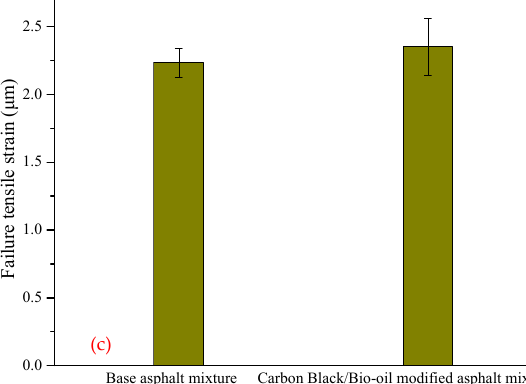
Figure 8. Comparison of low-temperature splitting test results of different asphalt mixtures. ( a ) Splitting tensile strength; ( b ) Failure stiffness modulus; ( c ) Failure tensile strain.